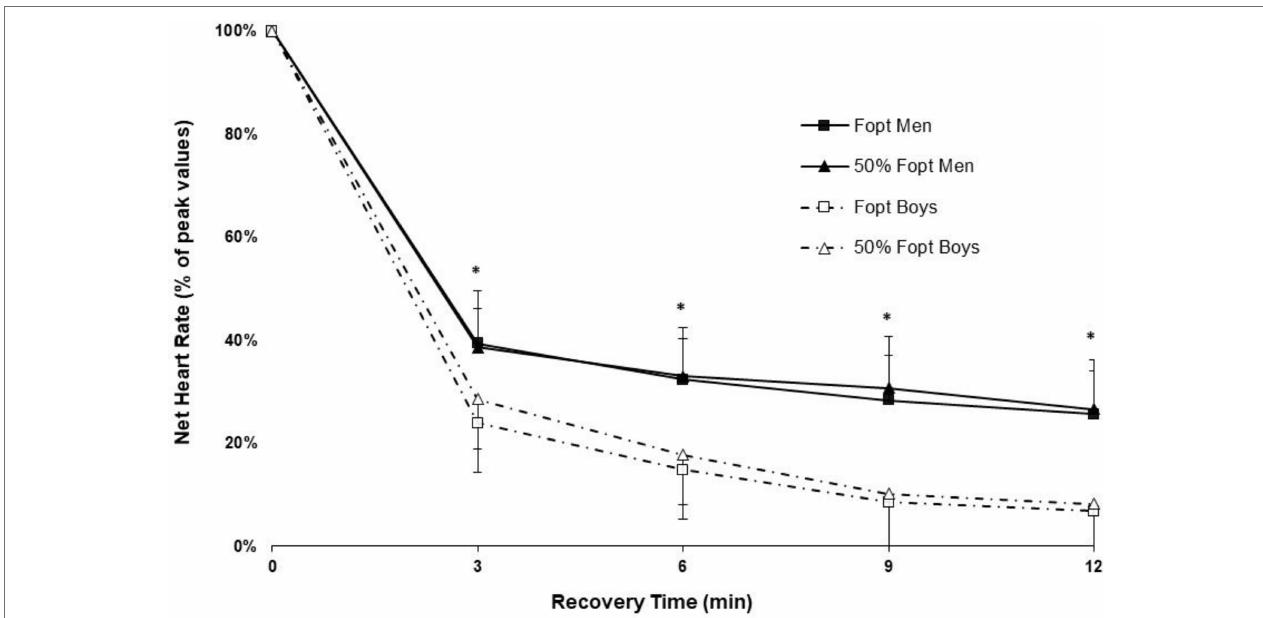
FIGURE 4 | Heart rate (HR) recovery after 10 repeated cycling sprints at light (50% Fopt) and heavy resistive loads (Fopt) in boys and men. Values are net change of HR (current HR—pre HR), expressed as a percentage of the difference between peak HR and pre HR. *Significantly different between boys and men in both conditions; p <